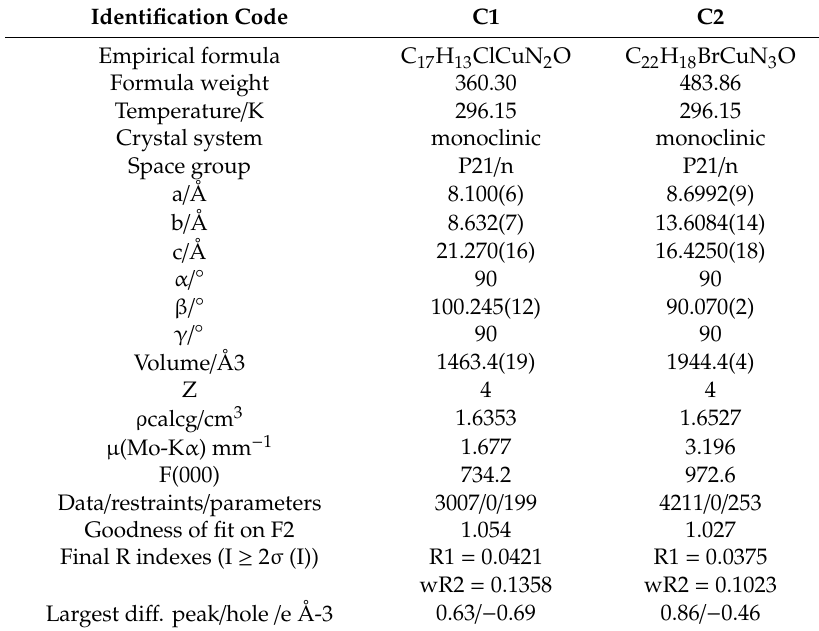
Table 1. Crystal data of the Cu (II) complexes ( C1 and C2